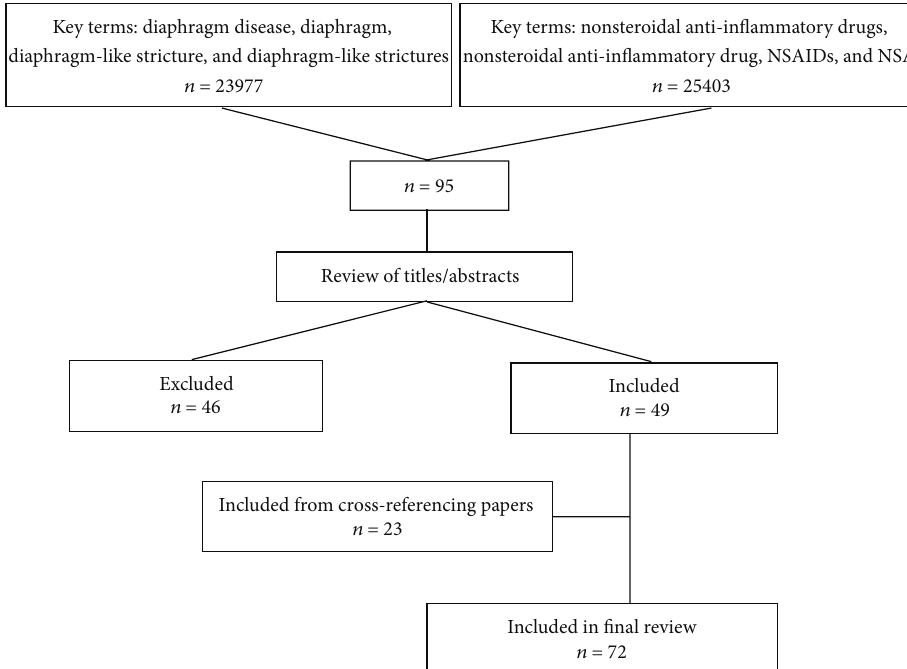
Figure 1: Literature search and management